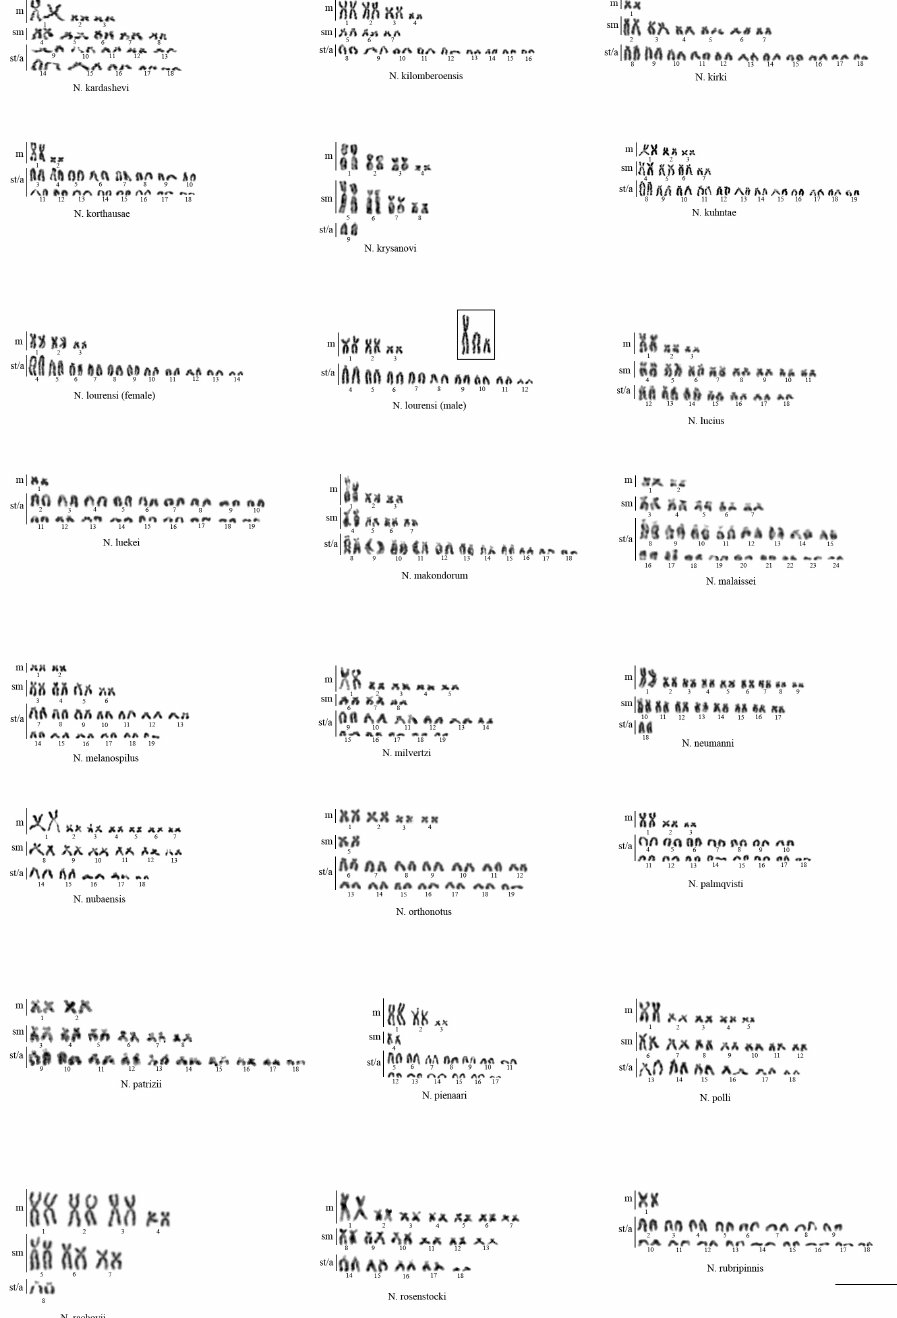
Figure 1. Continued. Karyotypes of species Nothobranchius . Scale bar: 10